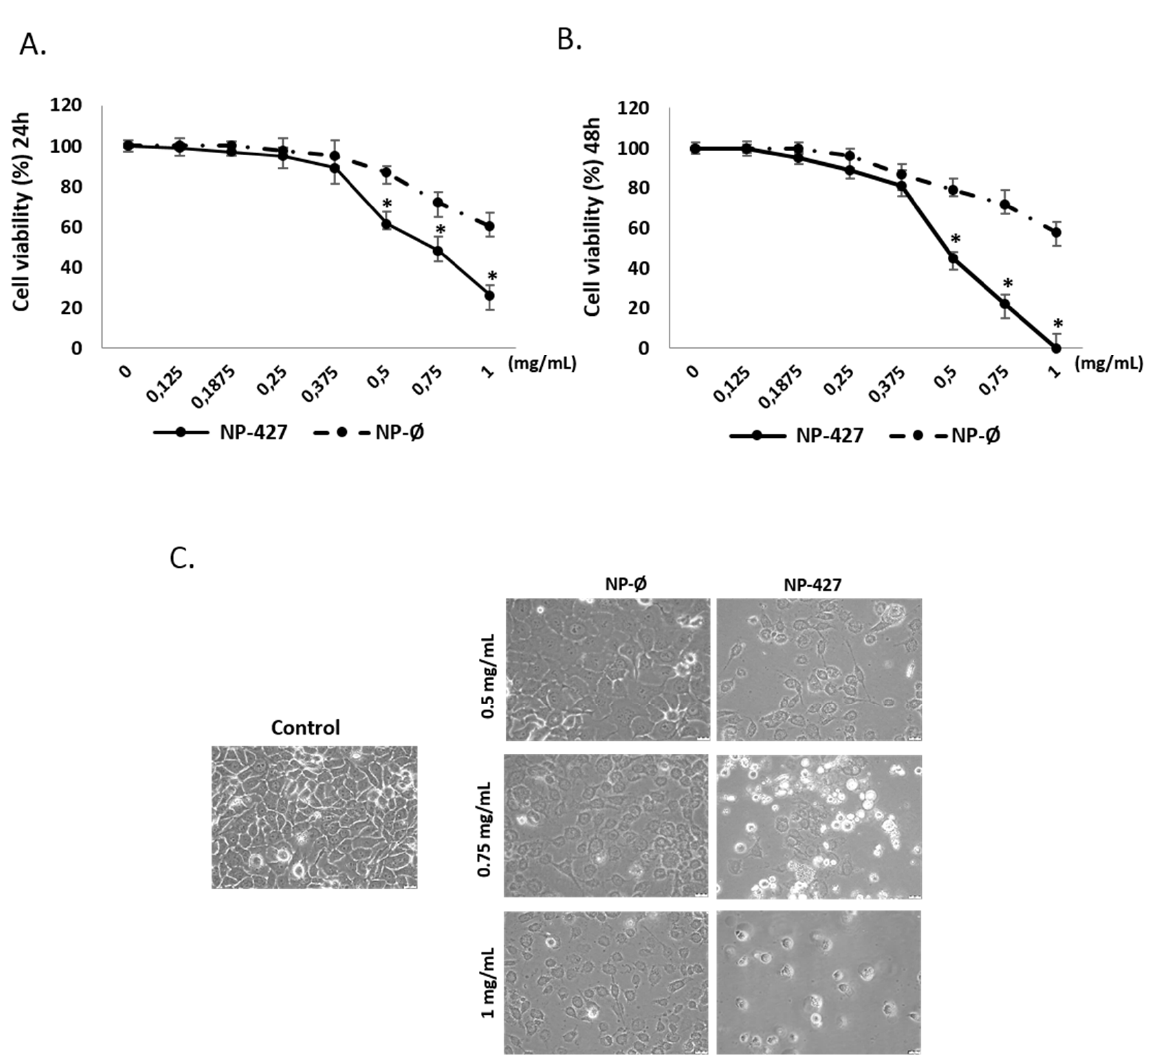
Figure 2. Inhibition of the proliferation of FaDu cells treated with NP-427. The FaDu viability of cultures measured by Alamar blue at 24 ( A ) and 48 ( B ) hours treated with NP-Ø (unloaded NPs) at 0, 0.125, 0.1875, 0.25, 0.375, 0.5, 0.75, and 1 mg/mL and NP-427 (PHT427-loaded NPs) at 0, 0.125, 0.1875, 0.25, 0.375, 0.5, 0.75, and 1 mg/mL. The curves include the mean, the standard deviation ( n = 3), and the analysis of variance (ANOVA) results (* p < 0.05 statistically significant difference with vs. NP-Ø group). ( C ) Representative optical micrographs of FaDu cells at 24 h of treatment (40×). Scale bar 100 µm.